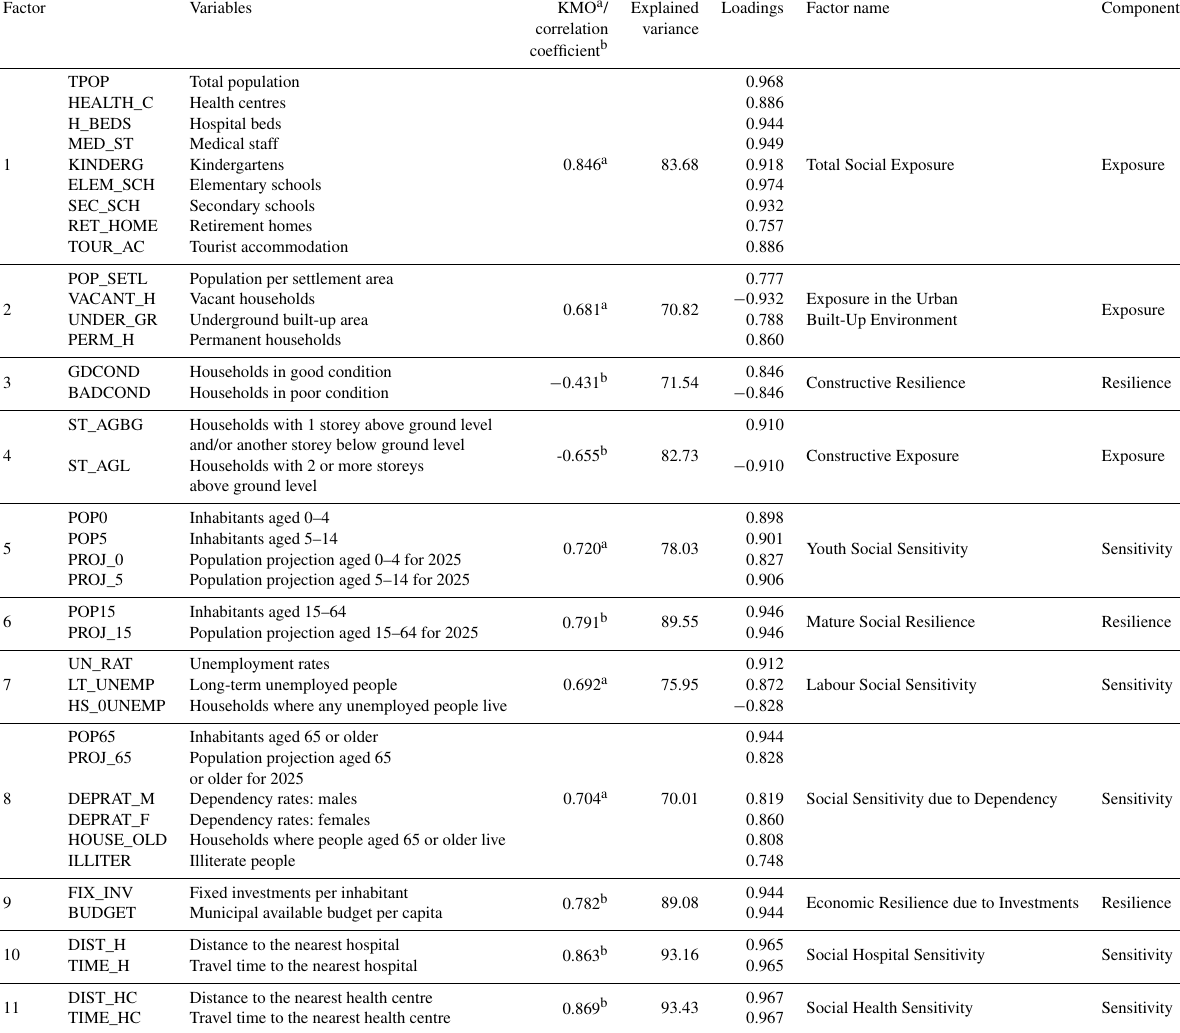
Table 2. Vulnerability factors identified with the PCA and additional statistical information (PCA results). The sign of the variable loadings indicates whether the correlation among variables making up a certain vulnerability factor is positive or negative. Factor Component